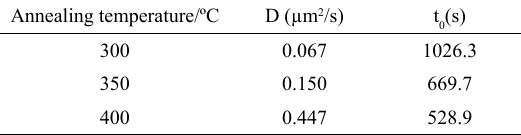
Figure 6. The increment of the width of the interfacial transition zone at different annealing temperatures for different annealing times ( ∆ X is the increment of the width of interfacial transition zone). Table 3. Kinetic parameters at various annealing temperatures.